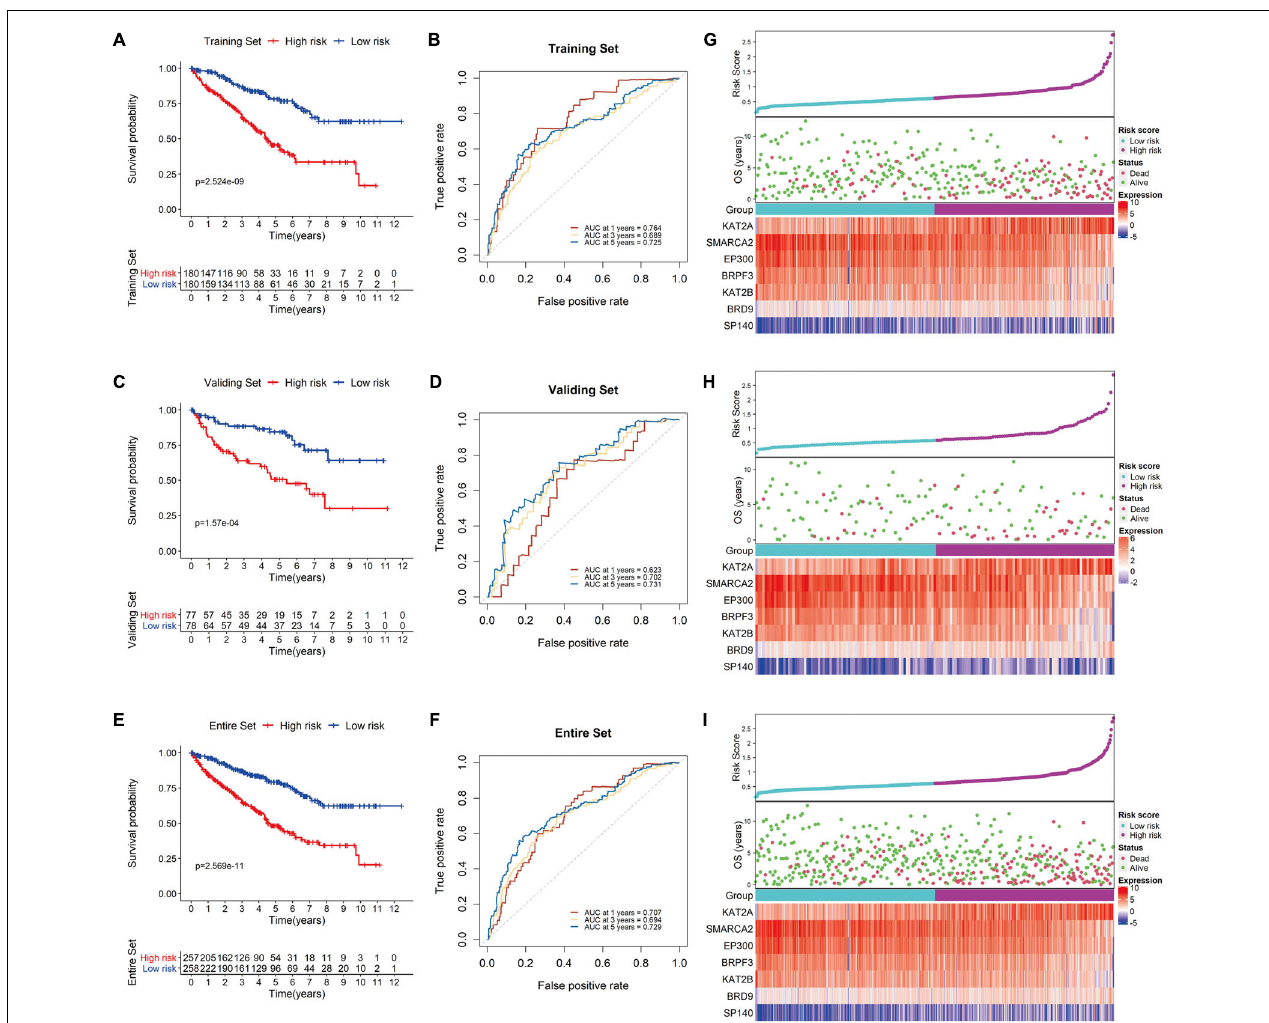
FIGURE 5 | Validation of the signature. Kaplan-Meier survival analysis for low- and high-risk KIRC patients from TCGA based on our signature in the training set (A) , the validation set (C) , and the entire set (E) ; prediction of recurrence risk in the training set at 1 − , 3 − and 5-year periods with BRD gene signature ROC analysis (B) , the validation set (D) , and the entire set (F) ; the distribution of risk scores, OS and the final status and the expression patterns of the prognostic BRD genes in the training set (G) , the validation set (H) , and the entire set (I) .